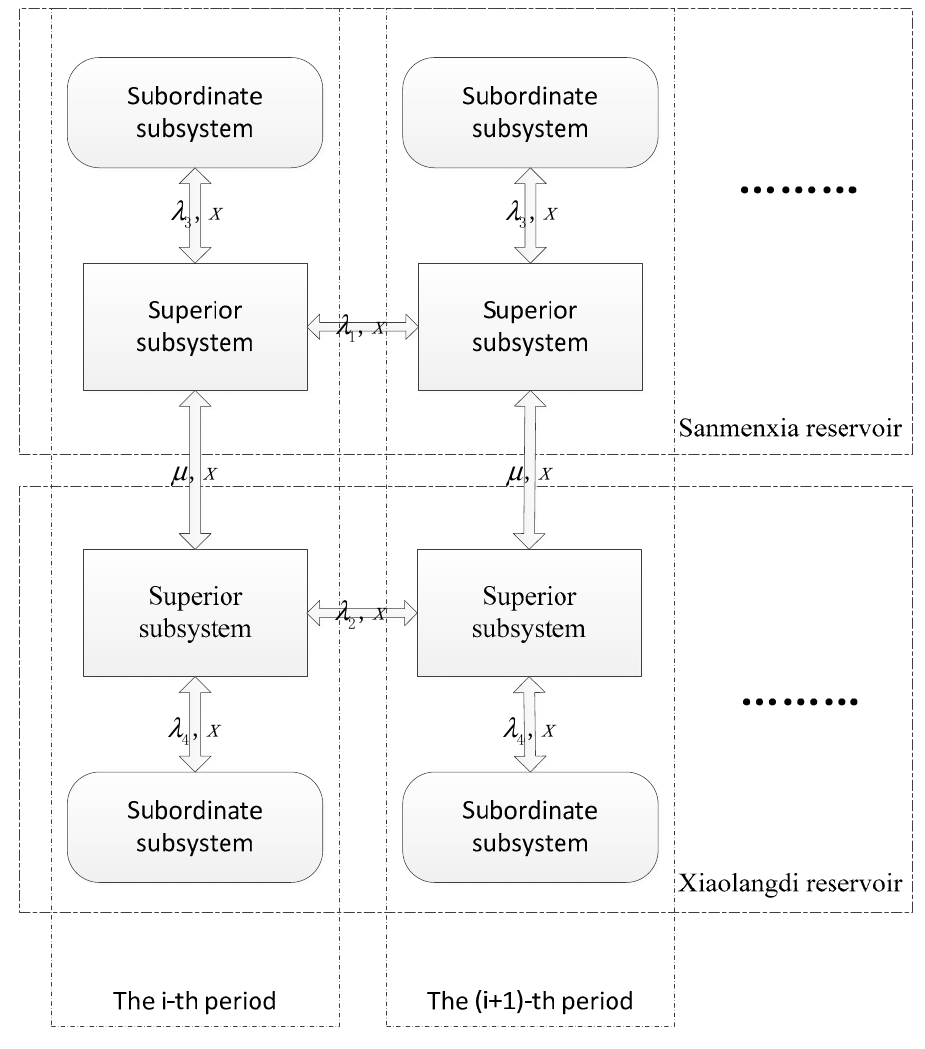
Figure 2. Information transfer structure diagram of the model.